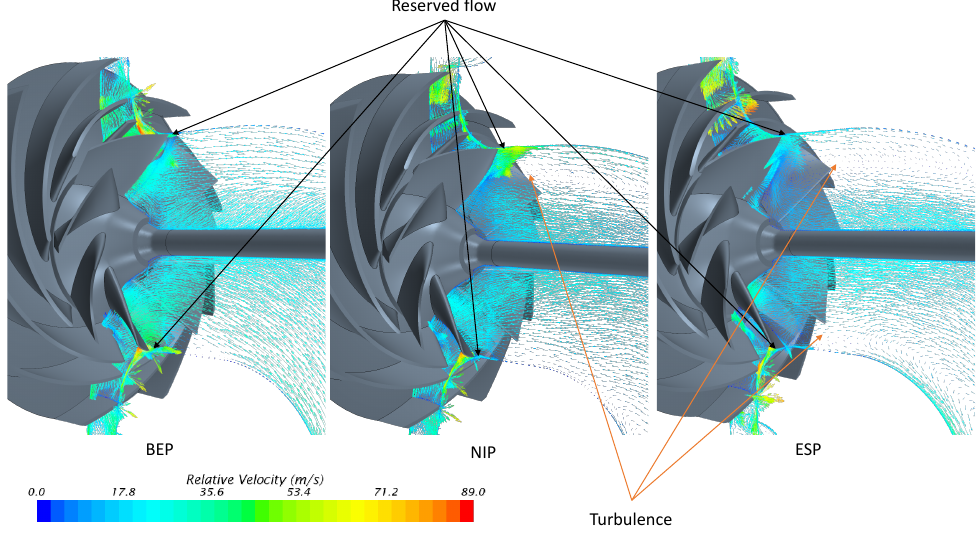
Figure 11. Inlet flow structure of three operating